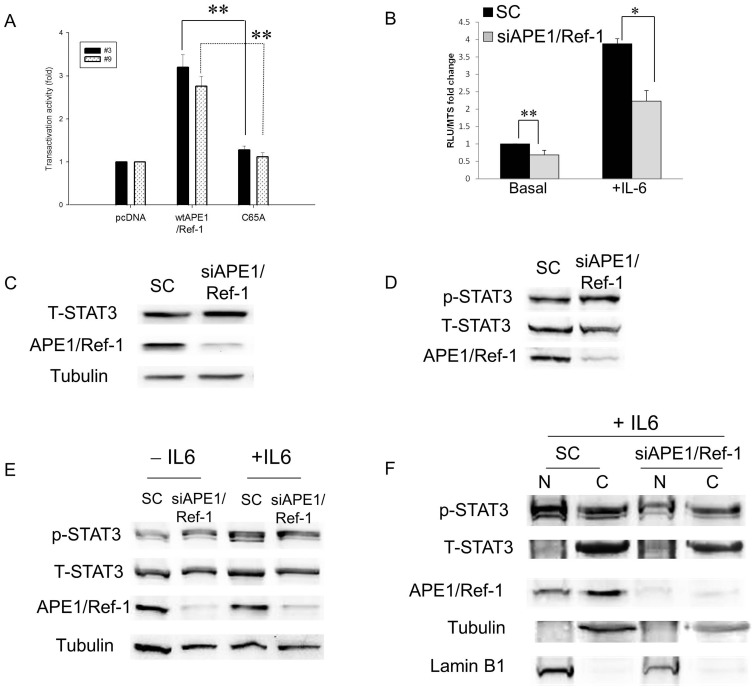
Effects of modulation of APE1 expression on STAT3 transactivation in PDAC cells.A) Panc-1 cells transiently transfected with pcDNA3, pcDNA3-wt-APE1, or pcDNA3-C65A-APE1 were assayed for STAT3 activity via luciferase reporter assay at 30 hr post-transfection. **p<0.01, n = 3 for each clone comparing wt to C65A. B) STAT3 Reporter assay of Panc-1 cells transfected with scrambled or APE1 siRNA (50 nM) and stimulated with IL-6 (50 ng/mL, 6 hr). * p<0.05, **p<0.01, n = 6 comparing SC to siAPE1. C) Western blot of total STAT3 protein levels following APE1 knockdown in PaCa-2 cells. Tubulin was used as a loading control. D) p-STAT3 (Y705) levels following APE1 knockdown in PaCa-2 cells. E) Immunoblots of whole cell extracts showing that stimulation with IL-6 (50 ng/mL, 3 hrs) increases p-STAT3 levels in both SC- and siAPE1- treated cells but does not change the levels of total STAT3 protein. F) Western blot of fractionated PaCa-2 cells stimulated with IL-6 and transfected with siRNA: nuclear (N) and cytoplasmic (C) fractions. Tubulin was utilized as a loading control for cytoplasm and Lamin B1 for nuclear.